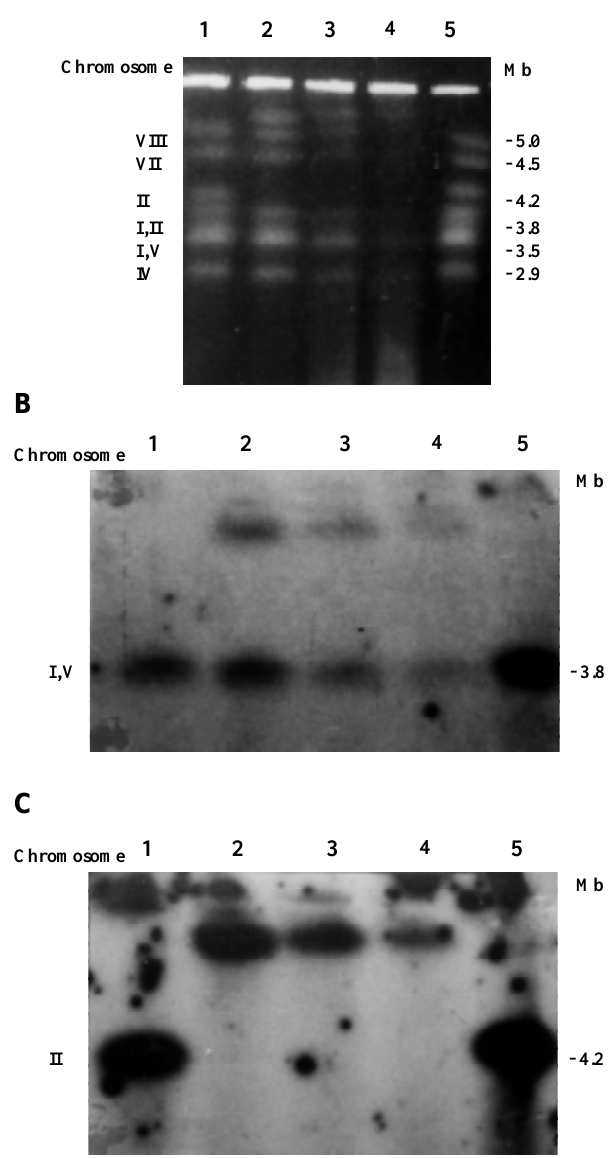
Figure 1 - Separation of Aspergillus nidulans intact chromosomal DNA on a CHEF gel (1A). The DNA was isolated from AM (lane 1), strain A (lane 2), strain B (lane 3), strain V17 (lane 4) and strain paba A1 (lane 5). B and C, the same DNA samples probed with the labeled genes uap A and w A,